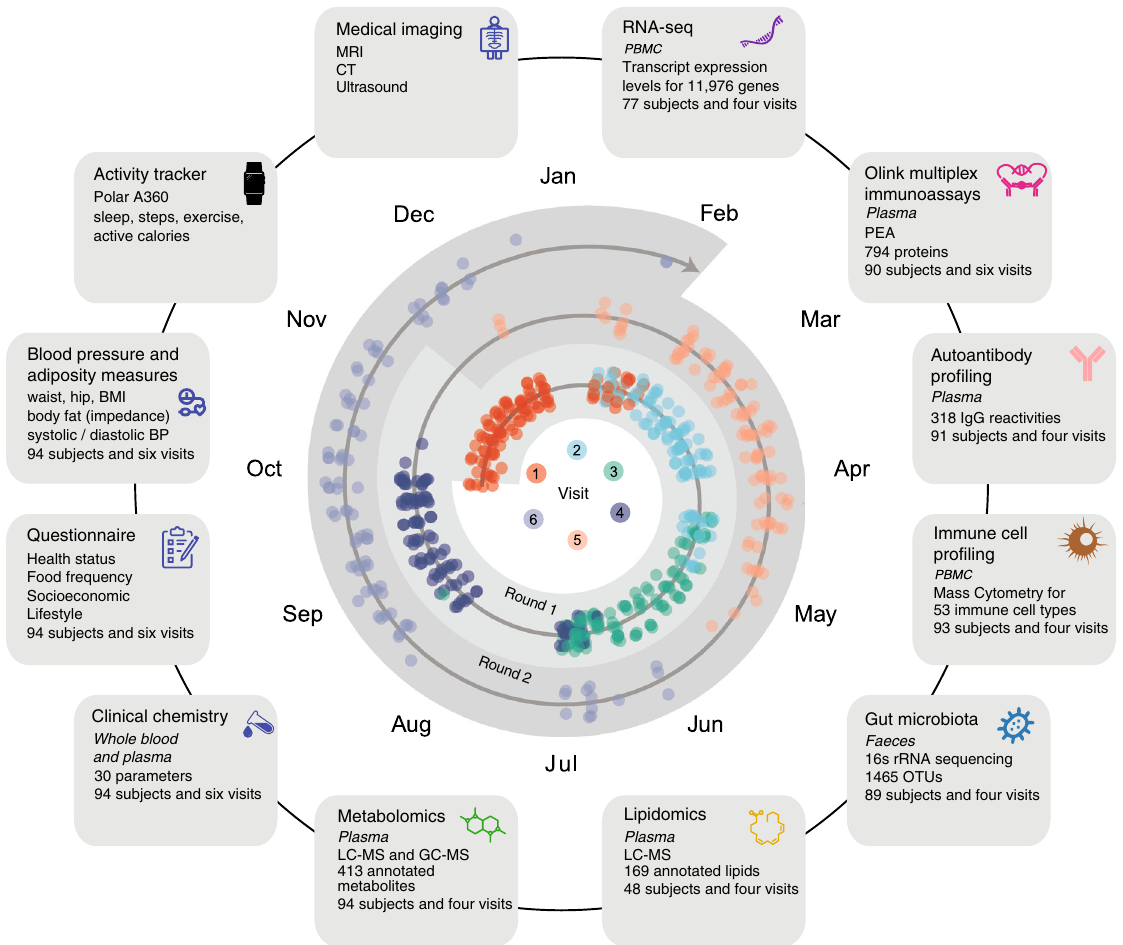
Fig. 1 Overview of the S3WP program. The outer part represents all types of data that have been analyzed for this study. The inner part shows the distribution across the months of a year for all visits for each of the 94 subjects that completed the program, where round one includes visits one to four with approximately three months intervals and round two includes visits 5 and 6 with ~6 months intervals. PBMC peripheral blood mononuclear cell; PEA Proximity Extension Assay; OTUs operational taxonomic units; IgG Immunoglobulin G; rRNA Ribosomal Ribonucleic Acid; LC – MS liquid chromatography – mass spectrometry; GC – MS gas chromatography – mass spectrometry; BP blood pressure; BMI body mass index; MRI Magnetic resonance imaging; CT computed